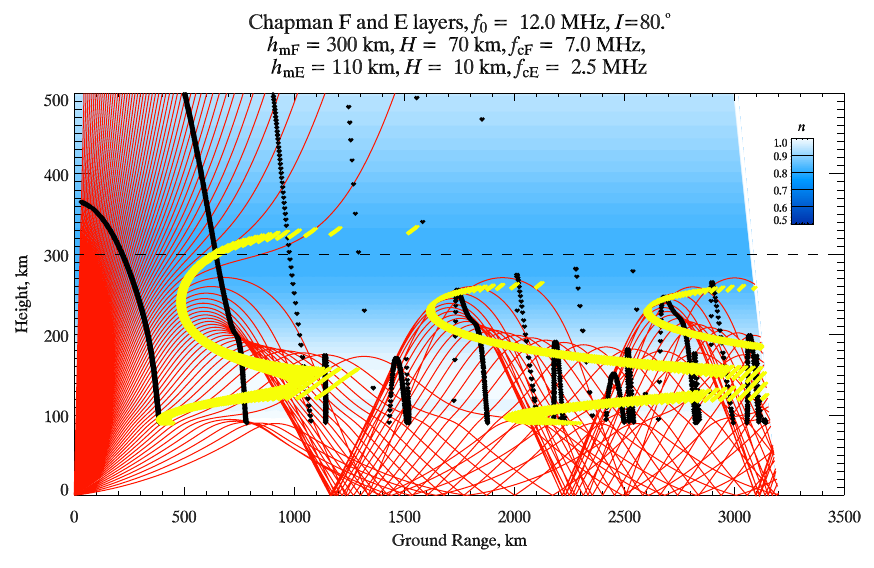
Fig. 6. Ray trajectories (red) simulated for a spherical geometry and Chapman E and F layers (solid line in Fig. 5) over a typical SuperDARN ground range span ’ 3200km. The data are presented in a “straightened” height-ground range format with different vertical and horizontal scales allowing for better visual analysis of the HF propagation details. The black and yellow colours, as in Fig. 1, describe range marks with a 400km step and aspect areas, respectively, while the blue shading shows spatial variations of the refractive index.